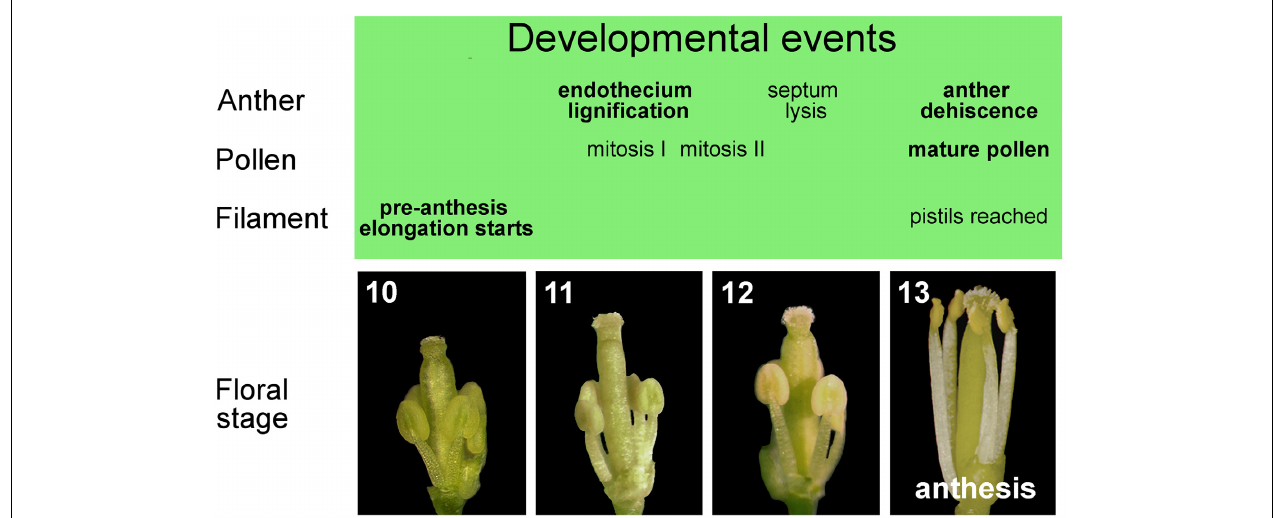
FIGURE 2 | Late development of stamens in flower buds from stages 10 to 13. Main events in the development of anther, pollen, and filament occurring in stamens during late flower